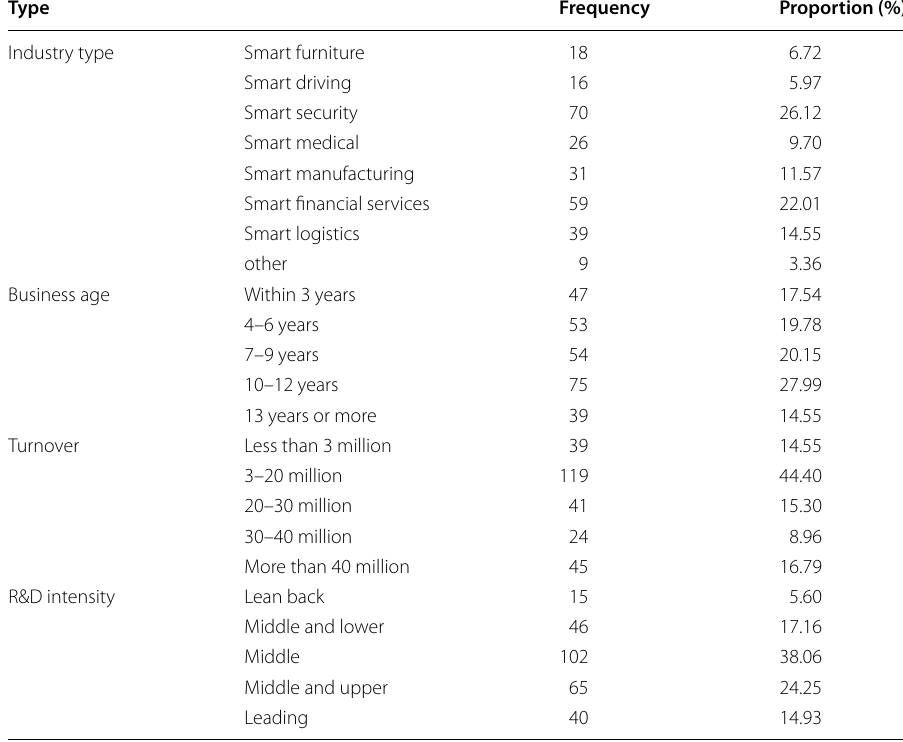
Table 2 Basic situation of the sample